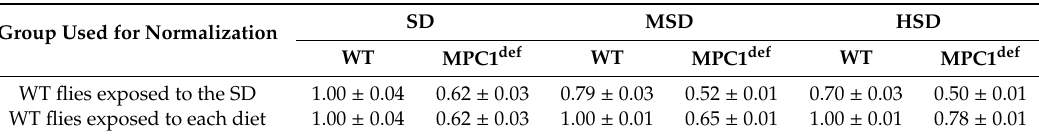
Table 1. MPC1 relative gene expression measured in the wild-type (WT) and MPC1 def genotypes of Drosophila melanogaster exposed to the di ff erent diets (Standard Diet (SD), Medium-Sucrose Diet (MSD), or High-Sucrose Diet (HSD)): N = 5 for each genotype fed with each diet. Relative gene expression was calculated with the ∆∆ Cq method with rps20 as the reference